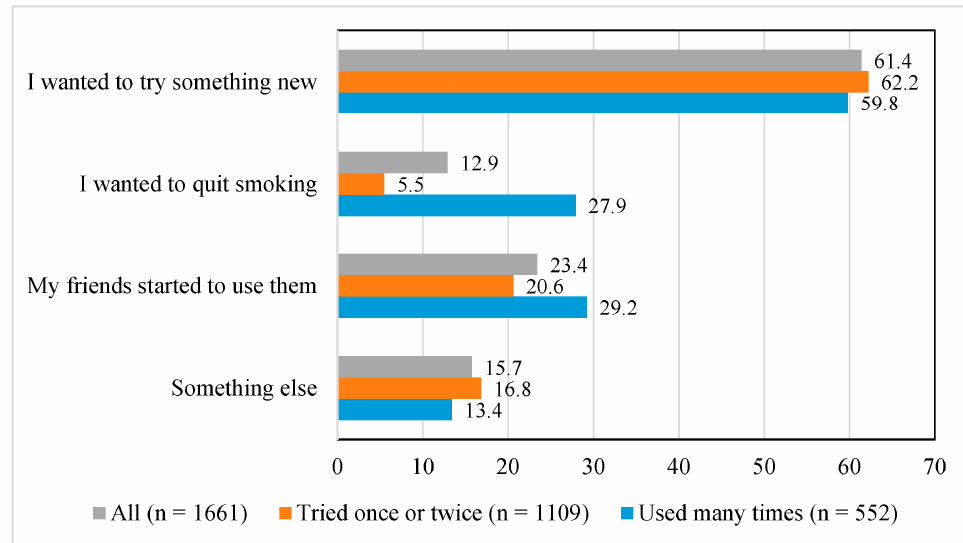
Figure 1. Reasons for e-cigarette experimentation and use among all e-cigarette ever-users and by the frequency of e-cigarette use in 2015, %. frequency of e-cigarette use in 2015,